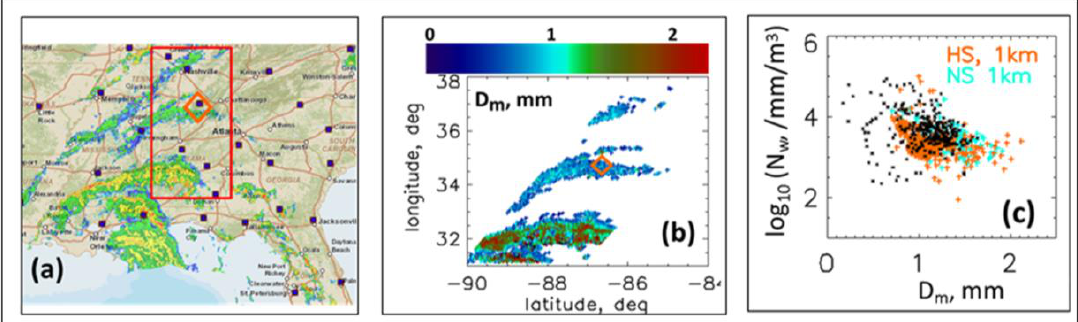
Figure 8. ( a ) Composite radar image of tropical storm Nate during the GPM satellite overpass over HSV on 07 Oct 2017 at 22:55 UTC, with the orange diamond representing the location of the ground instruments; ( b ) values of D m from the DPR retrievals at 1 km above ground, within the region marked as red box in ( a ); ( c ) log 10 ( N w ) versus D m from the GPM-DPR retrievals from the high sensitivity DPR scans (orange) and the normal sensitivity scans (cyan) for the region in Panel ( b ), compared with those derived from the ground-based composite DSDs (black asterisks) over several hours during Nate.